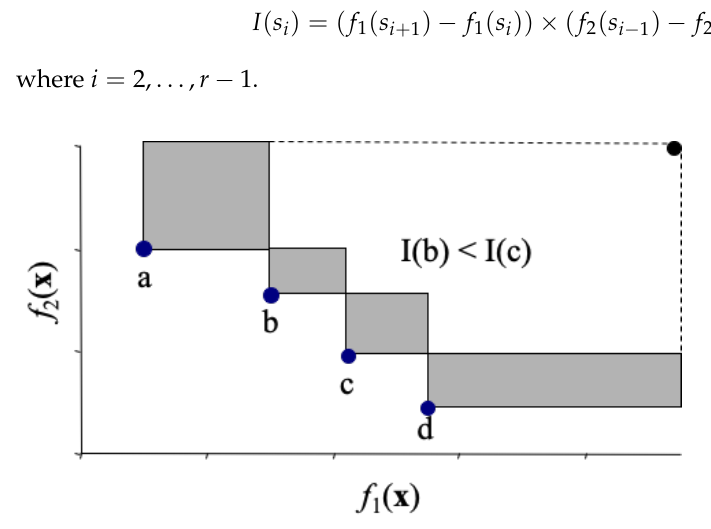
Figure 8. Hypervolume contribution.